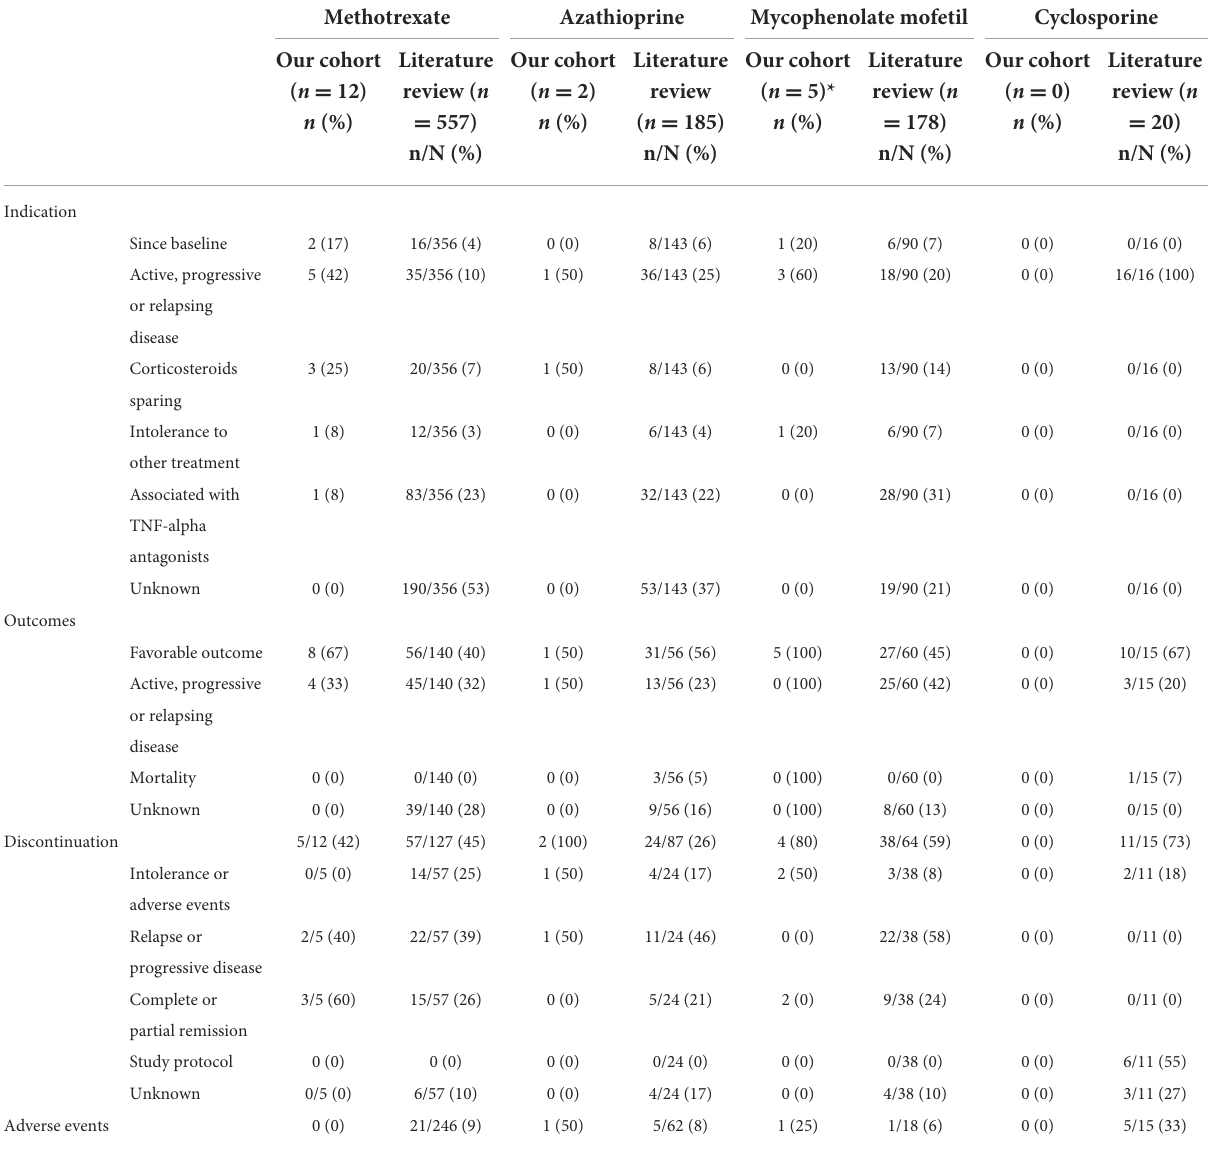
TABLE 6 Indication, outcome, reasons for discontinuation, and adverse events according to the second-line therapy at baseline and during follow-up in patients from our cohort and the